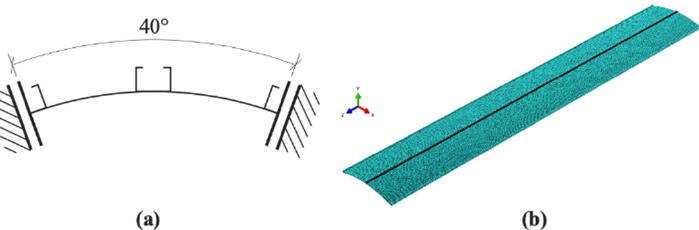
Figure 11. The studied silo segment: ( a ) scheme of boundary conditions (simplified); ( b ) numerical model. Source: [152].